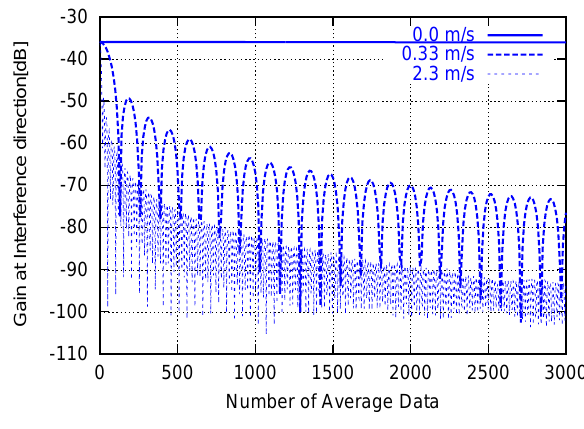
Fig. 9. Gain in direction of interferer for monochromatic signals with different Doppler velocities.